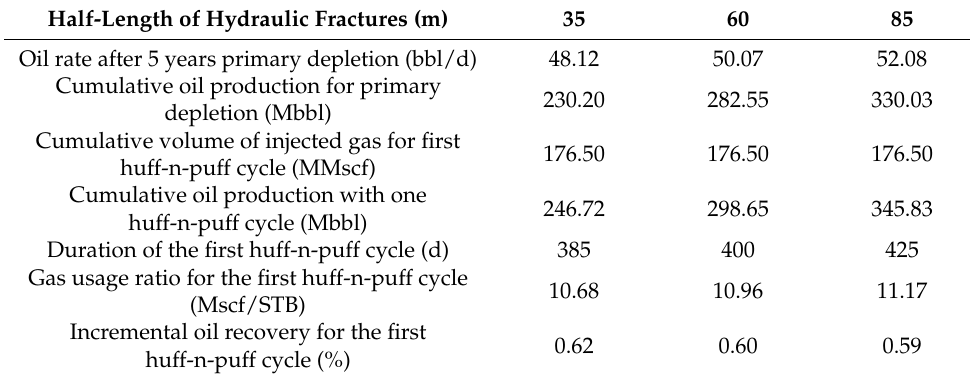
Table 13. Summary of results for huff-n-puff with different half-length of hydraulic fractures.